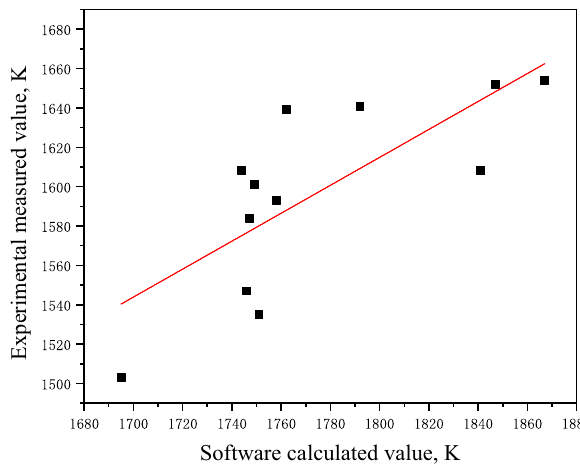
Figure 3: Relationship between software calculation of ash complete melting temperature and experimental measurement of ash melting